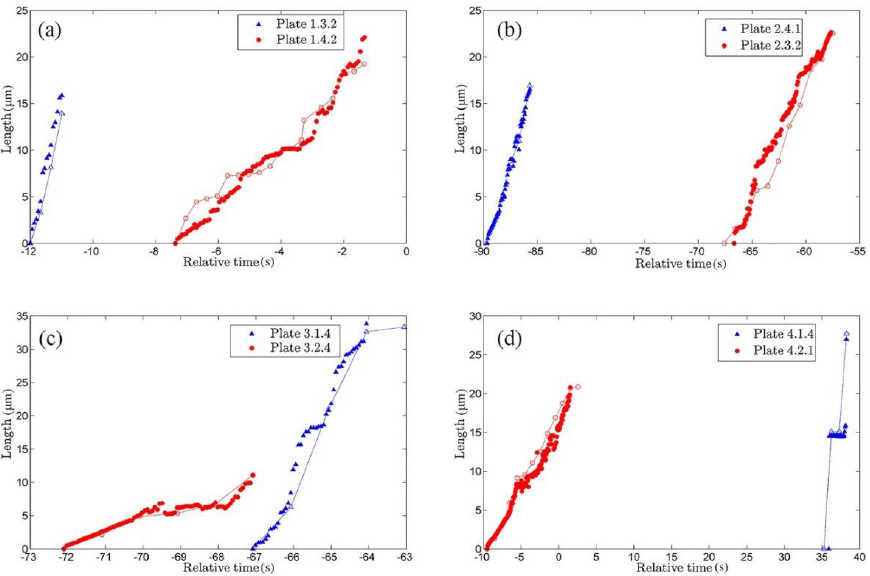
Figure 15. High time resolution measurements on plates observed in Fe-0.2C-1.5Mn-2.0Cr at isothermal holding conditions: ( a ) T = 723 K (450 °C); ( b ) T = 773 K (500 °C); ( c ) T = 823 K (550 °C); and ( d ) T = 923 K (650 °C).